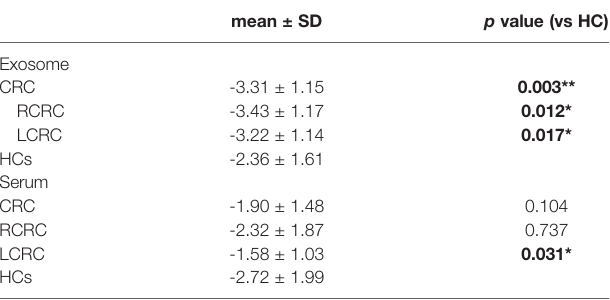
TABLE 2 | Correlation between circulating miR-1539 expression levels in CRC and